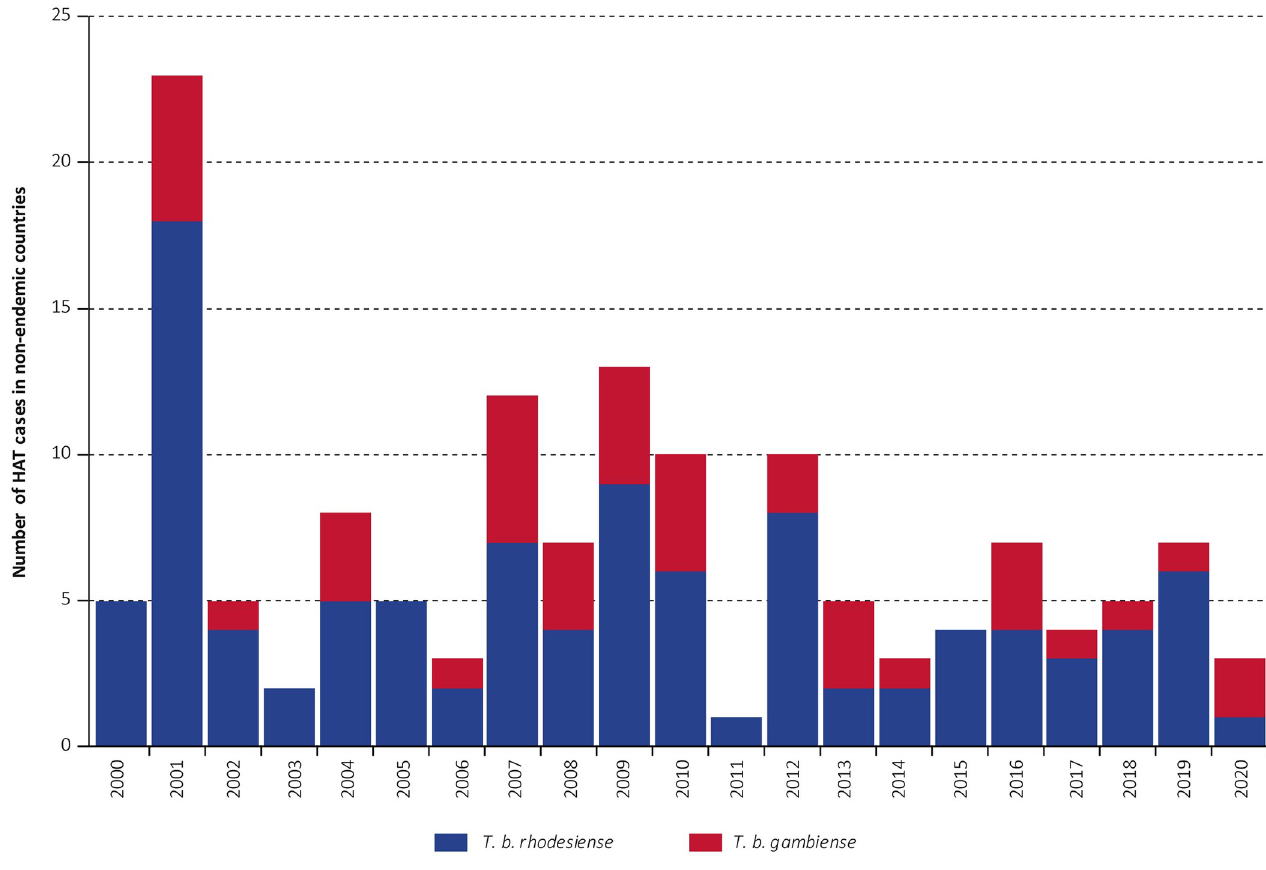
Fig 1. Cases of HAT detected in non-DEC.